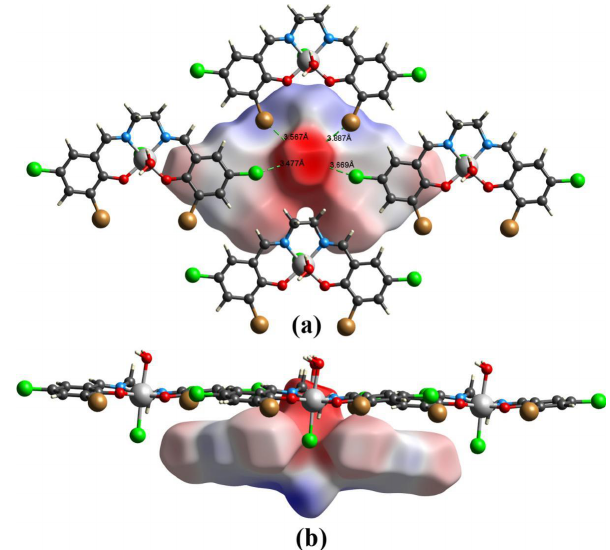
Figure 8. The three-dimensional map of the potential across the plane for quantifying the intermolecular interactions within the crystal structure. ( a ) C-X..Cl-Mn interactions between adjacent molecules; ( b ) XB induced layered structure.